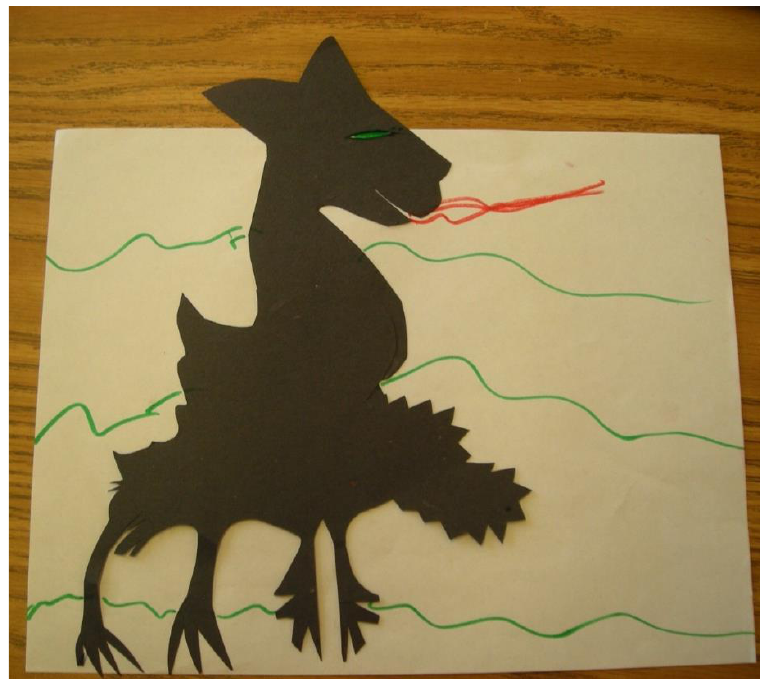
Figure 2. L’s cut paper monster emerges before her surgery.